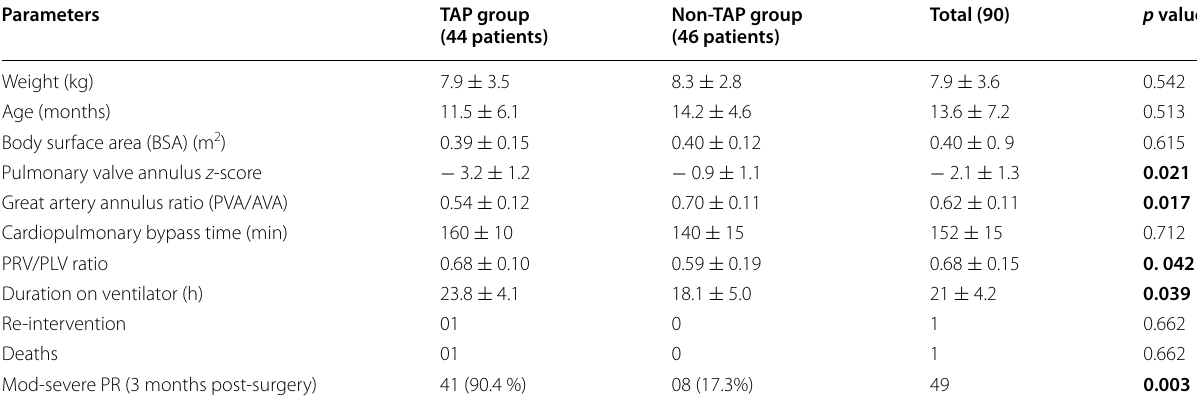
Table 1 Comparison of baseline parameters between the patients underwent transannular patch enlargement (TAP group) and who did not (non-TAP